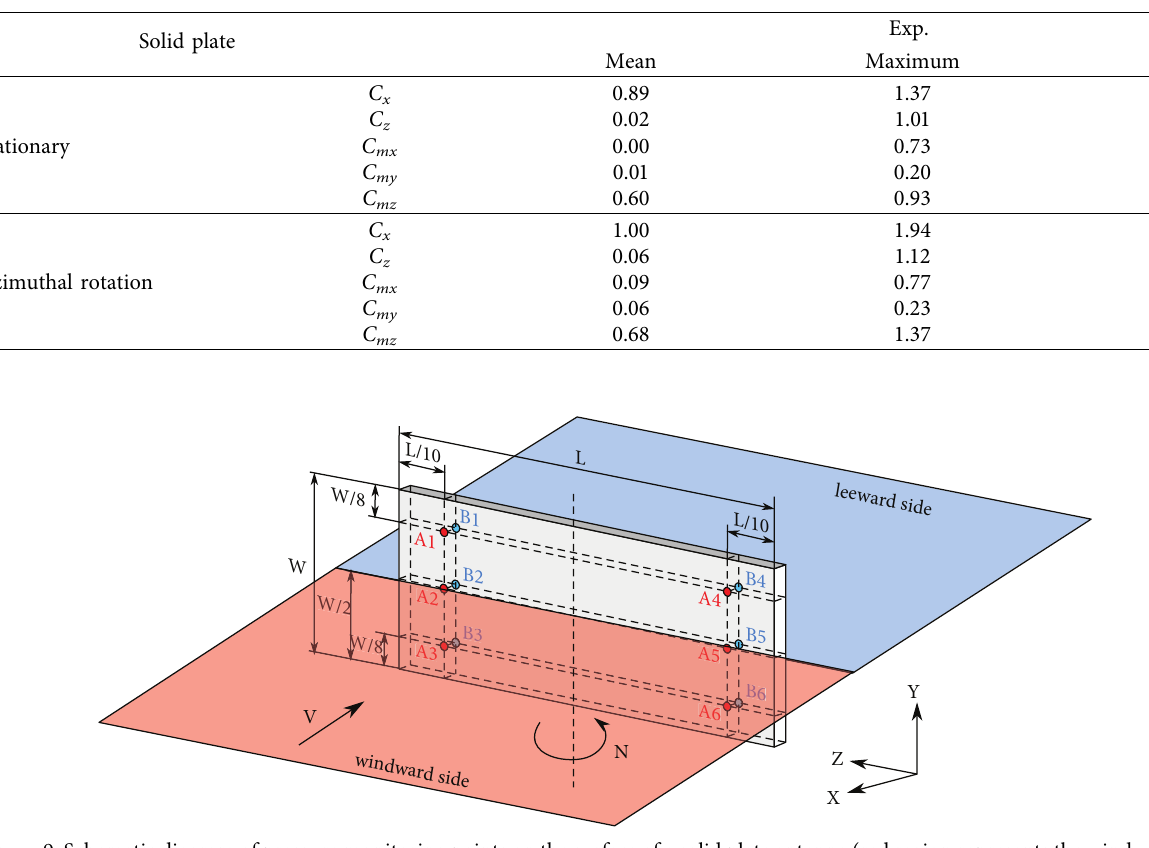
Figure 9: Schematic diagram of pressure monitoring points on the surface of a solid plate antenna (red region represents the windward side of the antenna, blue region represents the leeward side of the antenna, and rotation is